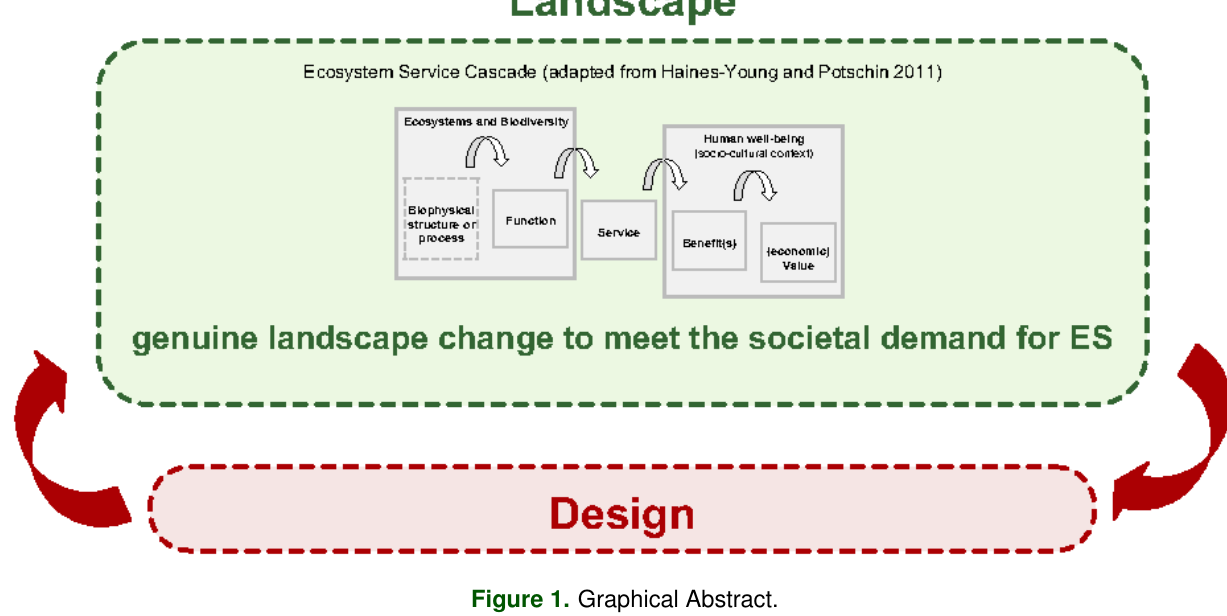
Figure 1. Graphical